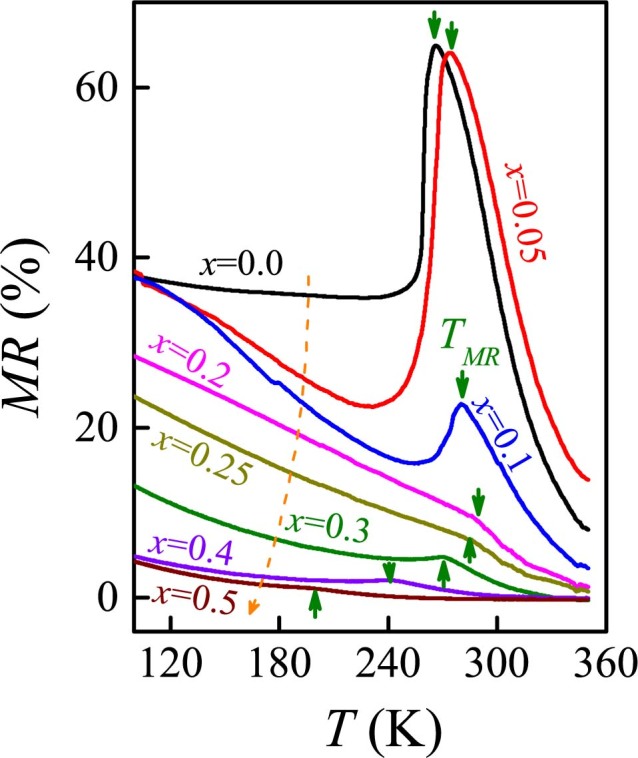
Measured MR(T) for a series of samples.The dashed arrows show the y sequence (y = 0.0, 0.05, 0.10, 0.20, 0.25, 0.30, 0.40, and 0.50). The MR peak point is TMR.